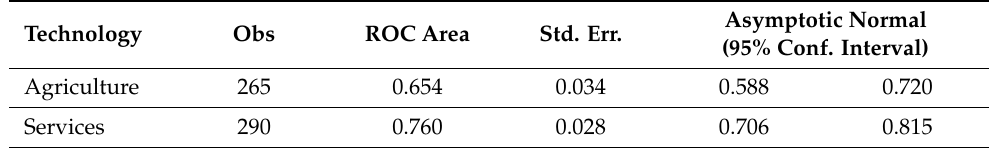
Table 17. Comparison of the ROC areas—sectoral subsample models (firms).